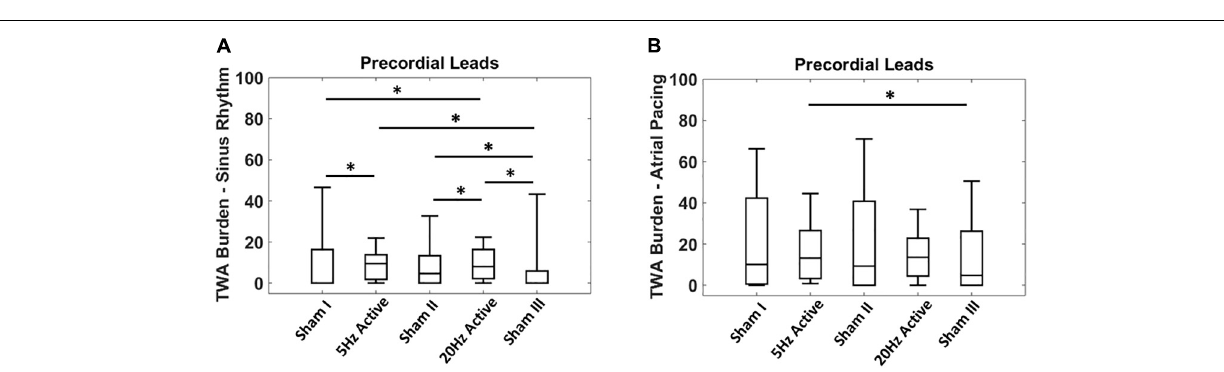
FIGURE 3 | Acute effects of low level tragus stimulation (LLTS) on T-wave alternans (TWA) burden. (A) TWA burden is significantly elevated with active LLTS at 5 Hz and 20 Hz, compared to sham LLTS during sinus rhythm. (B) Higher baseline TWA burden is observed during 100 bpm atrial pacing with no enhancement in TWA burden observed with active LLTS. “*” denotes statistical significance of p < 0.05 using Wilcoxon rank sum